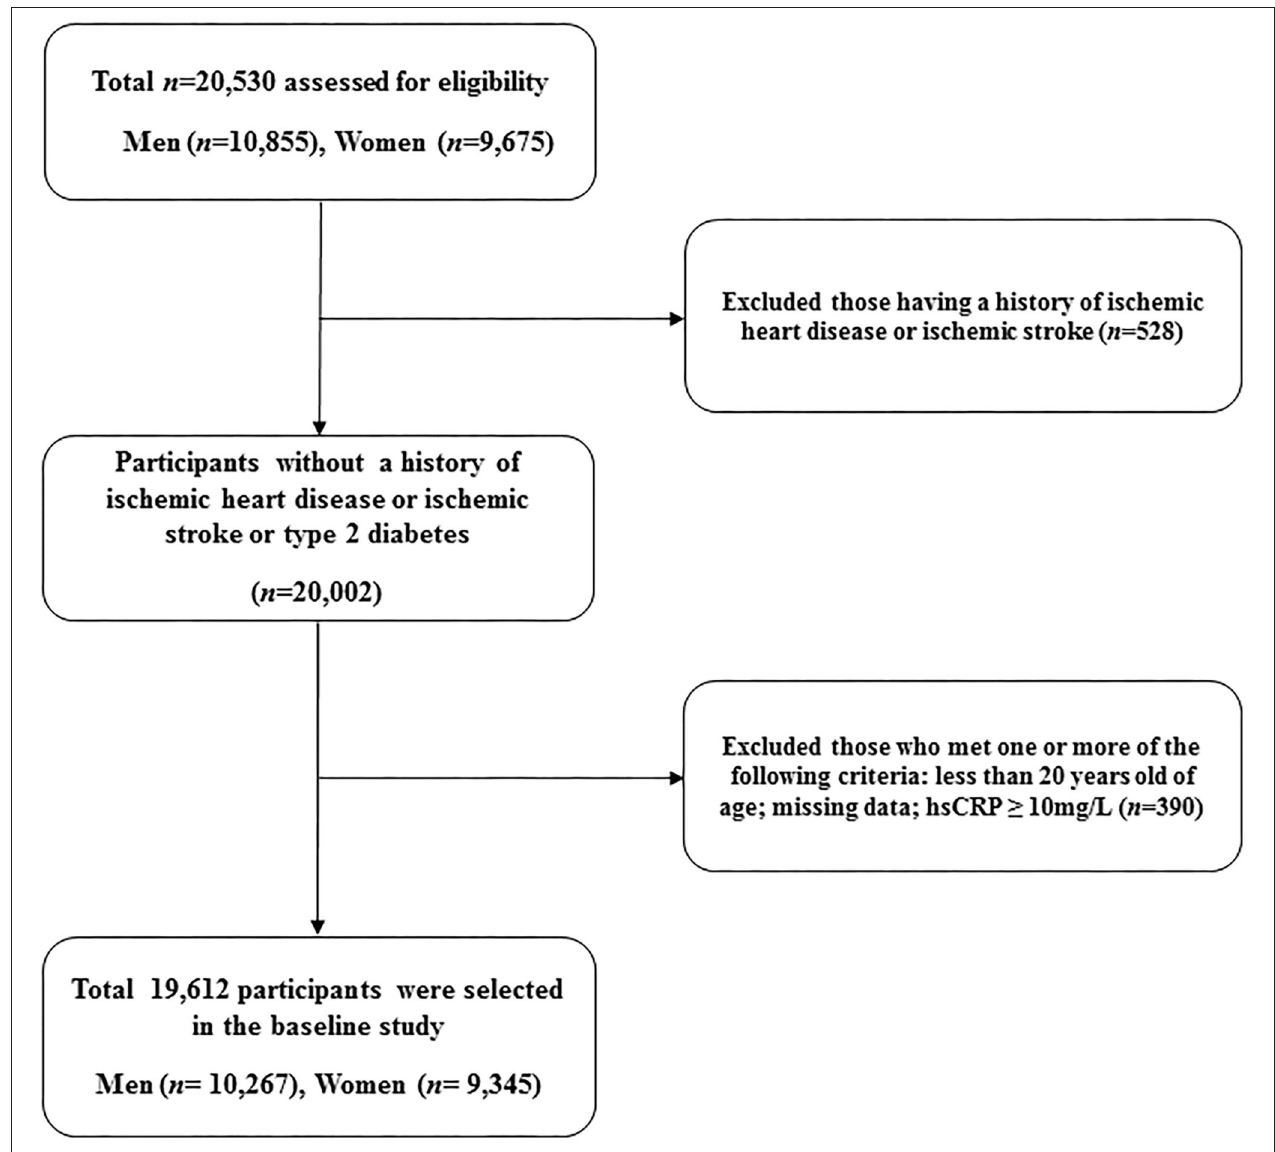
FIGURE 1 | Flowchart for the selection of study